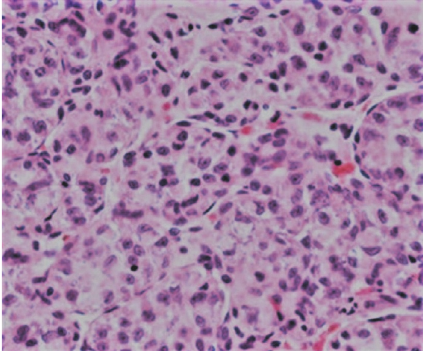
Figure 3: Hematoxylin-eosin, original magnification × 400. The figure shows large polygonal tumor cells in nests with eosinophilic cytoplasm and central vesicular nuclei with prominent